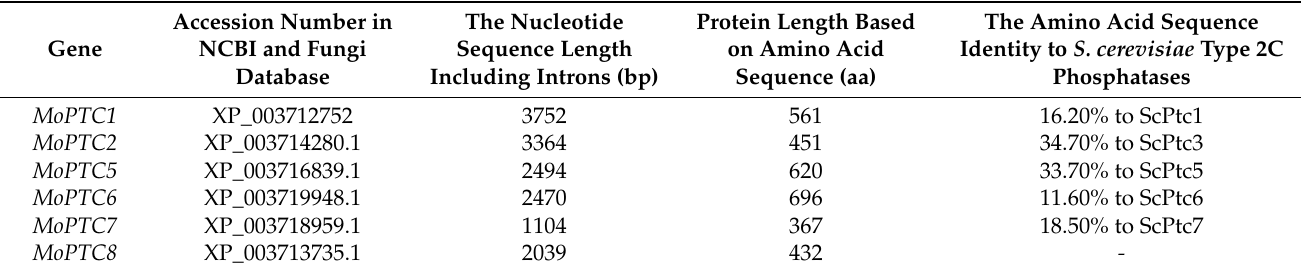
Table 1. Primary structure analysis of six type 2C protein phosphatases in M. oryzae